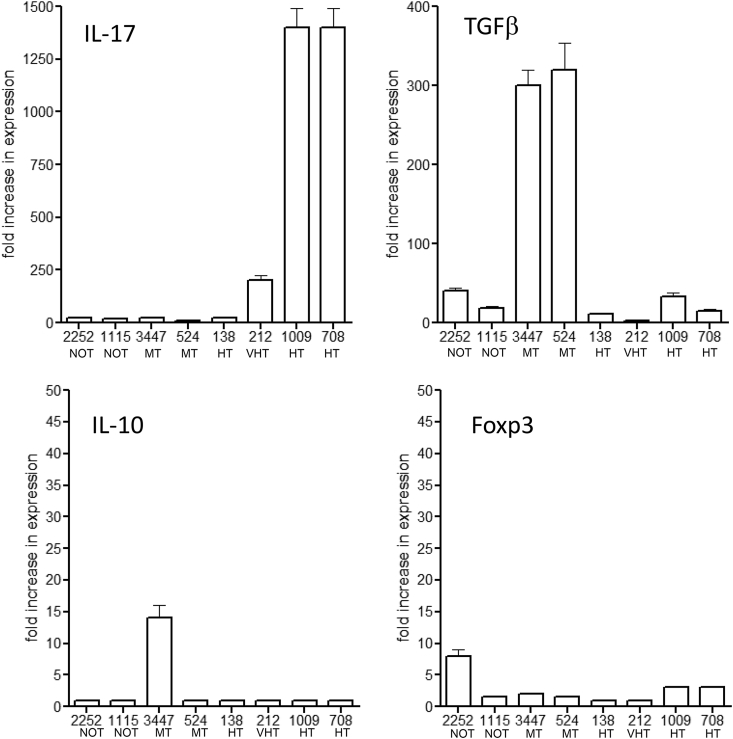
RT-PCR signals for key regulatory responses in the lungs of guinea pigs infected with a panel of clinical strains of M. tuberculosis. Data show as mean of three measurements ±SEM.